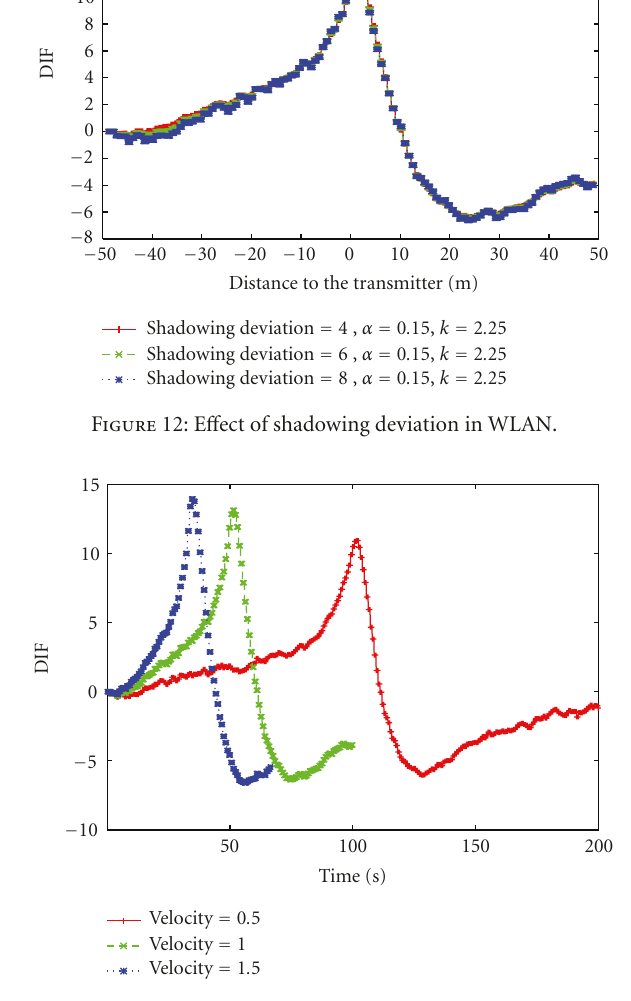
Figure 13: E ff ect of velocity in WLAN.